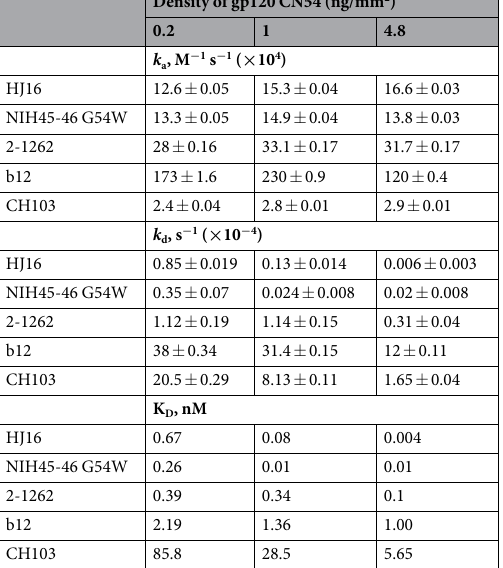
Table 1. Kinetics of interactions of human monoclonal Abs with gp120 CN54 as a function of immobilization density. All association rate constants were determined by global analyses of real-time binding, using Langmuir kinetic model. The dissociation rate constants of Abs b12 and CH103 were determined also by global analyses, whereas these constants for Abs HJ16, NIH45-46 G54W and 2-1262 were determined by separate Langmuir dissociation model at Ab concentrations of 100 nM in case of 2-1262, and 50 nM in cases of HJ16 and NIH45-46 G54W. The equilibrium dissociation rate constants were determined from the ration k d / k a . Standard errors of association and dissociation rate constants were derived by Biaevaluation software (global Langmuir analyses). In cases of separate determination of dissociation (Abs HJ16, NIH45-46 G54W and 2-1262) errors were determined by three independent fits of experimental